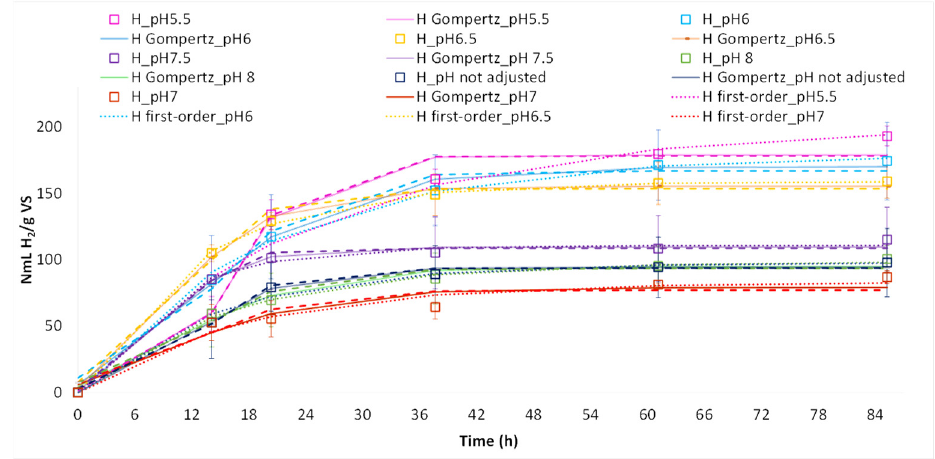
Figure 3. Cumulative H 2 production and three fitting models (i.e., modified Gompertz model, first- order, and modified Logistic model) curves under seven different initial pH conditions during the dark fermentation of a winter/autumn composition of fruit and vegetable waste.